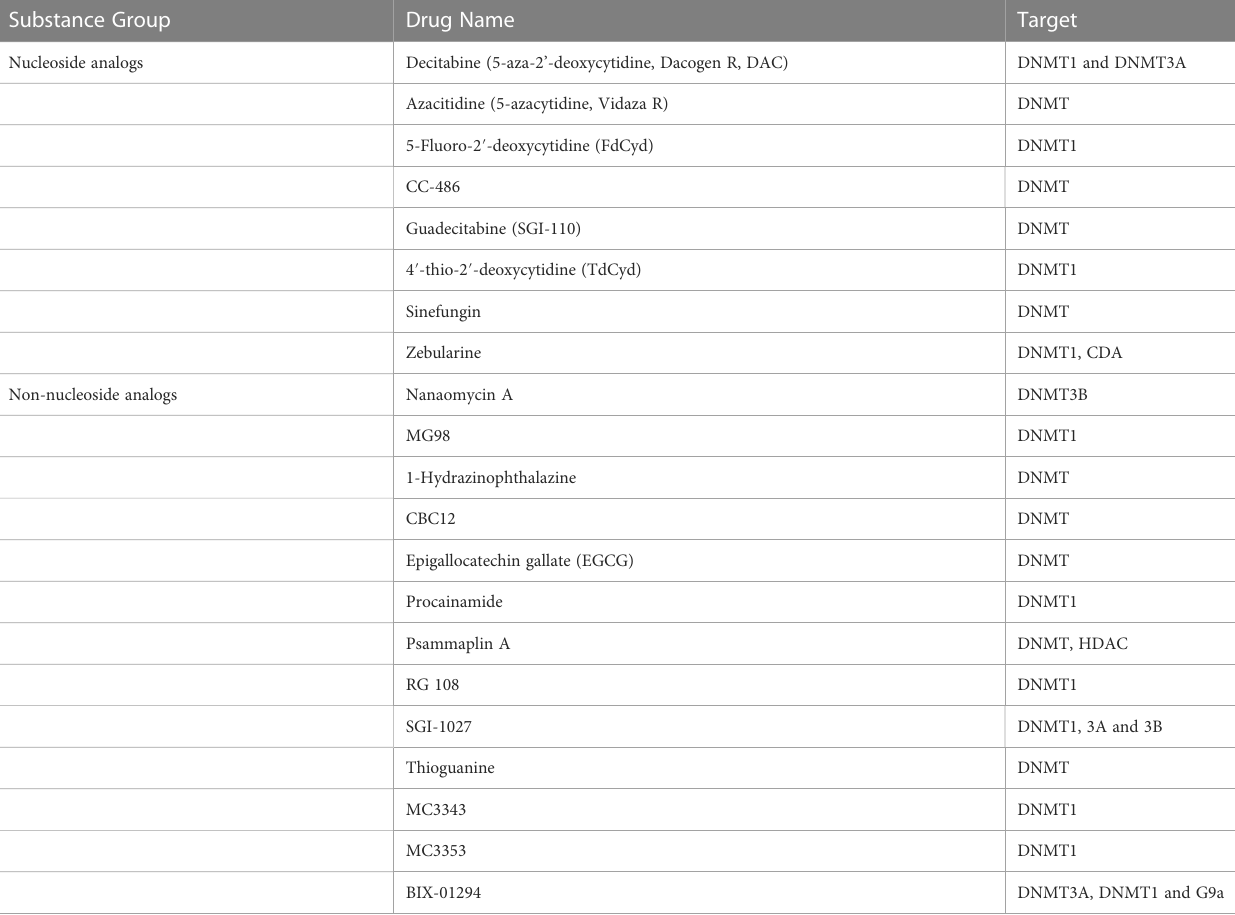
TABLE 3 Summary of DNA methyltransferase